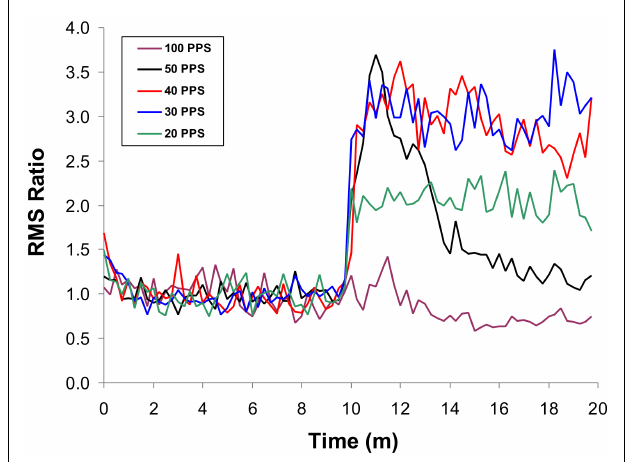
FIGURE 2 | Effects of LCN stimulation on mean MEP amplitude over time, showing frequency dependency of the response. The initial 10min of data represent the “off” LCN stimulation condition, followed by 10-min of “on.”The effects for each stimulation frequency are shown. All frequency conditions show an initial increase in MEP response magnitude at the start of LCN stimulation, except for 100Hz. At 50Hz, the effect is transient, with the response approximating baseline (“off”) levels by the end of the 10-min block. A similar but less dramatic pattern is seen for stimulation at 40Hz. The enhancement is sustained at both 20 and 30Hz but more pronounced at 30Hz.With permission from Elsevier Limited